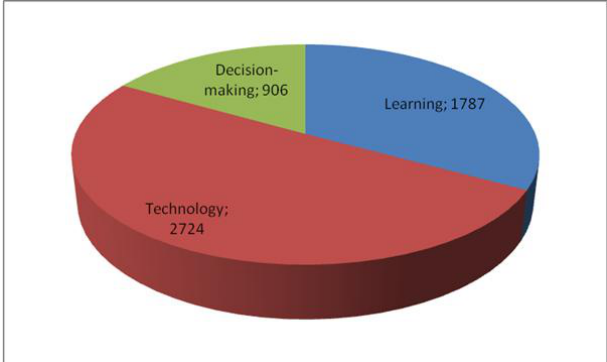
Figure 4 . Category and